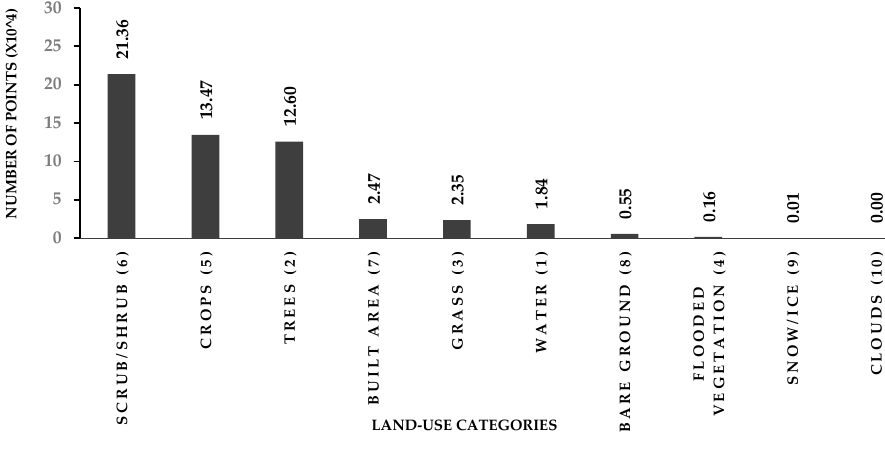
Figure 6. Frequency analysis for the extracted samples from the LULC 2020-ESRI dataset.